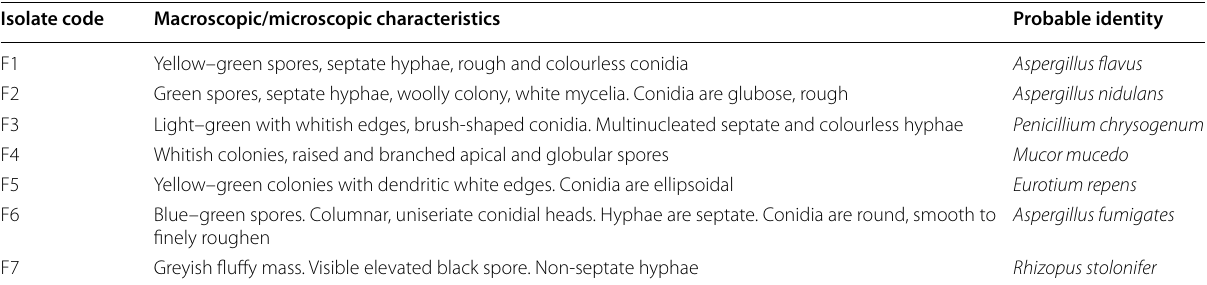
Table 2 Macroscopic and microscopic characteristics of fungal isolates from the polyethylene dumpsite soil Isolate